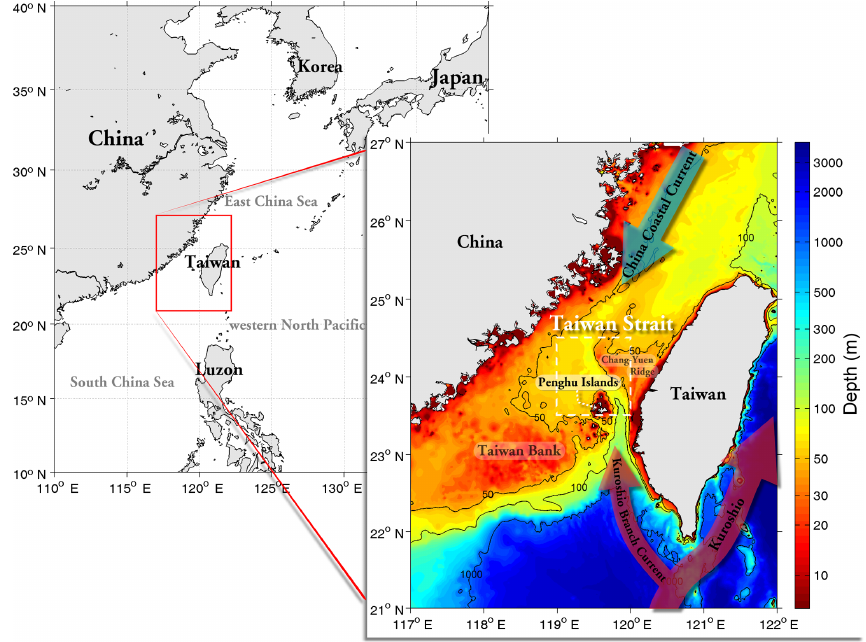
Figure 1. Bathymetric chart (shaded color) and sketches of the China Coastal Current, Kuroshio, and Kuroshio Branch